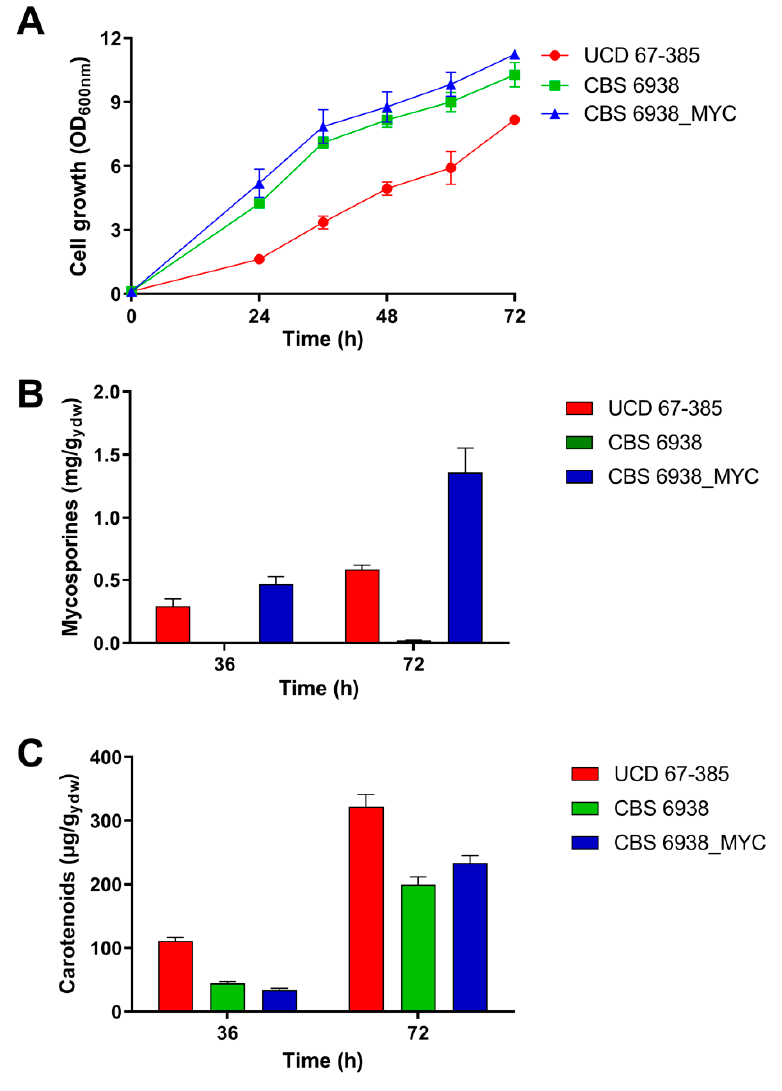
Figure 5. Phenotypic characterization of the transformant CBS 6938_MYC strain of P. rhodozyma . ( A ) Growth profile of the donor UCD 67-385, receptor CBS 6938 (wild type) and transformant CBS 6938_MYC. ( B ) Mycosporine production. ( C ) Carotenoid production. The strains were grown in 1% glucose-containing YM medium. Error bars represent standard deviation.